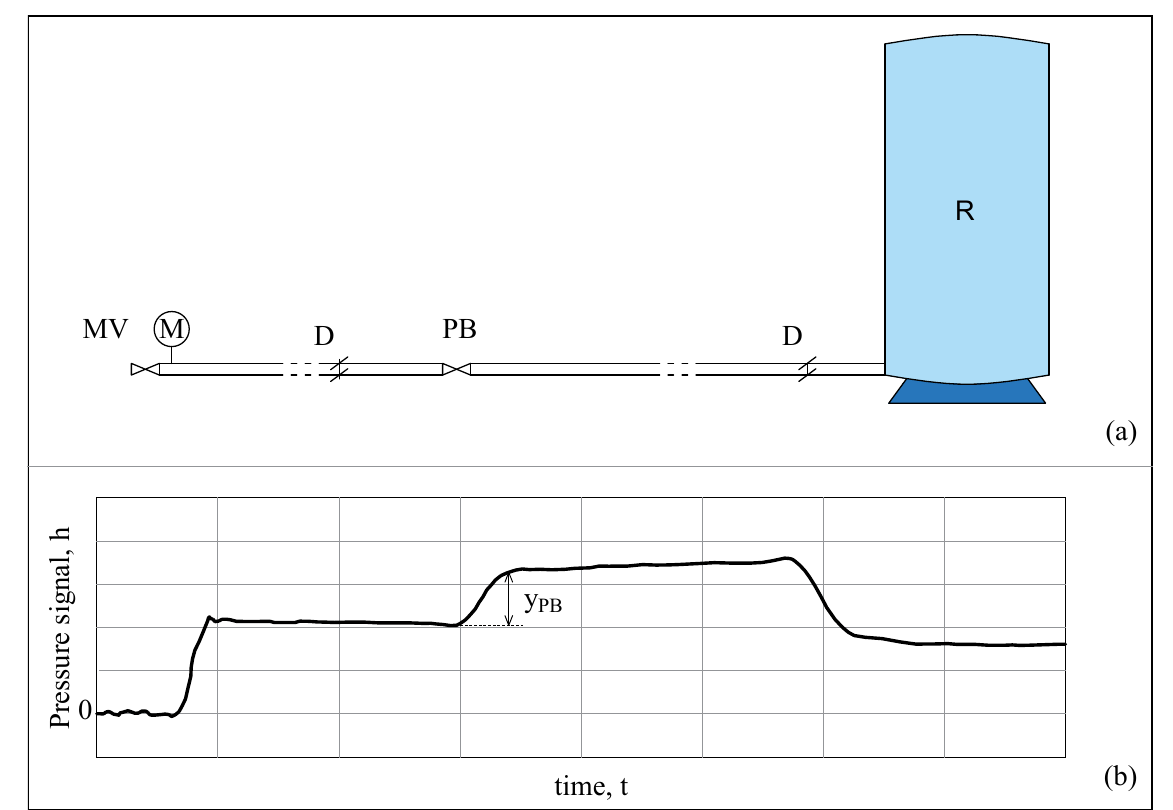
Figure 4. Partially closed in-line valve simulating a discrete partial blockage: ( a ) sketch of the experimental setup at the Water Engineering Laboratory (WEL) of the University of Perugia, Italy (MV = maneuver valve, M = measurement section, PB = (discrete) partial blockage, R = reservoir), and ( b ) pressure signal during the transient generated by the complete closure of MV (modified from